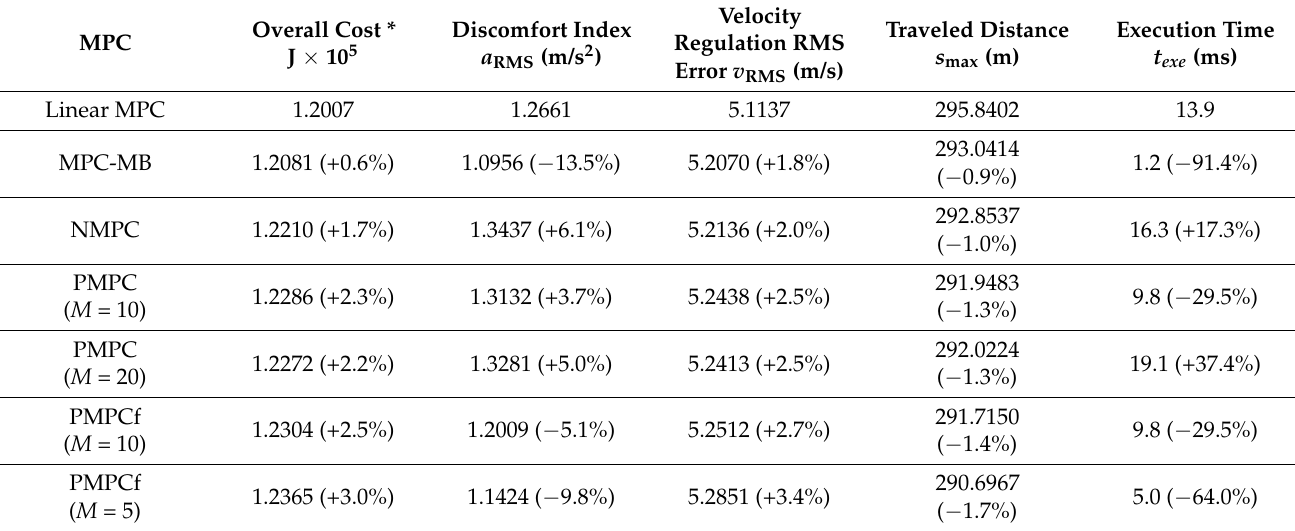
Figure 14. Comparative responses of position ( a ), velocity ( b ), acceleration ( c ), execution time ( d ) and time constant input ( e ) of NMPC, PMPC, and PMPCf systems. Table 1. Summary of performance metrics for presented